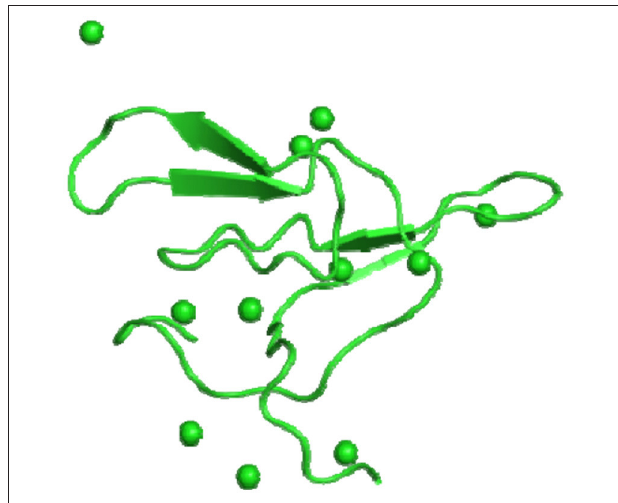
FIGURE 2 | IBB_LENCU—Bowman-Birk type protease inhibitor monomer from Lens culinaris (PDB id: 2aih).